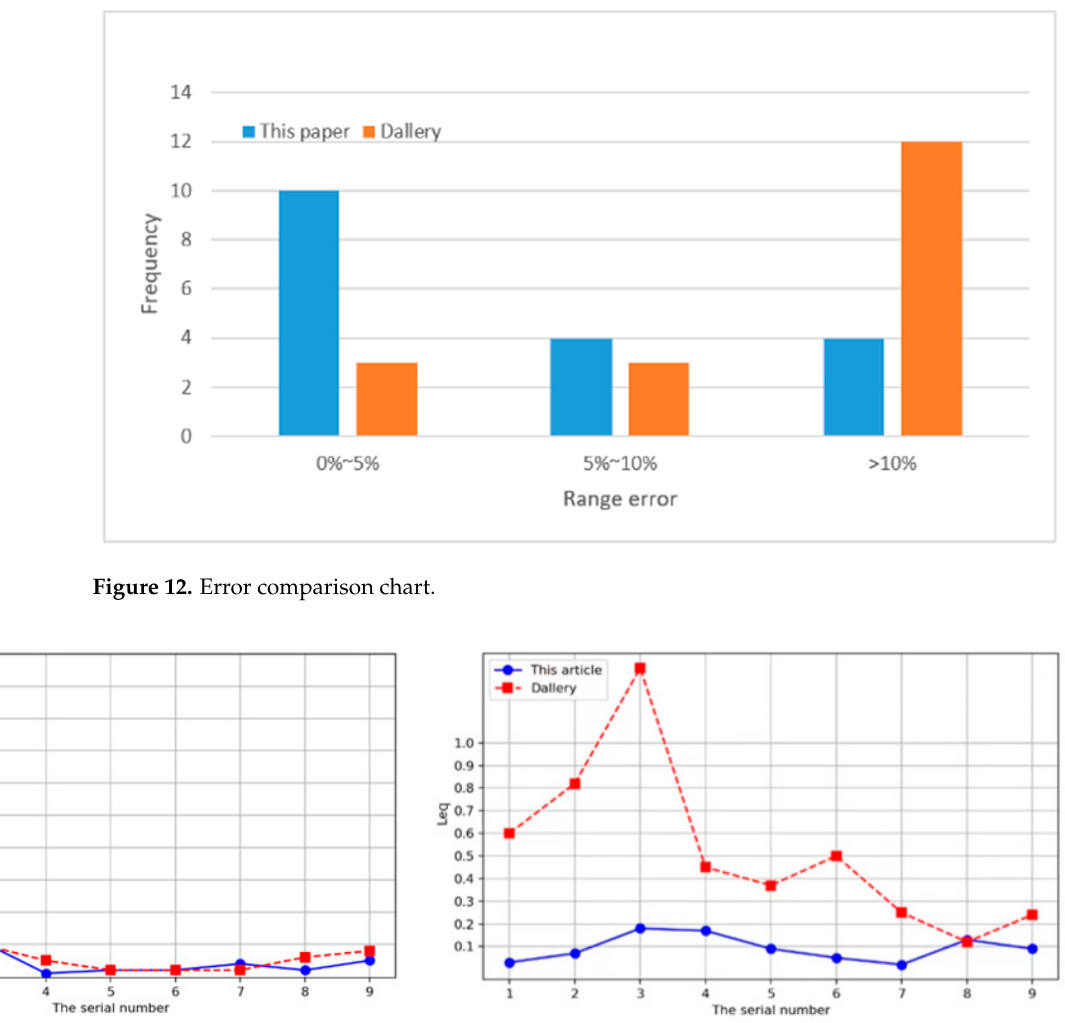
Table 9. System size parameters.